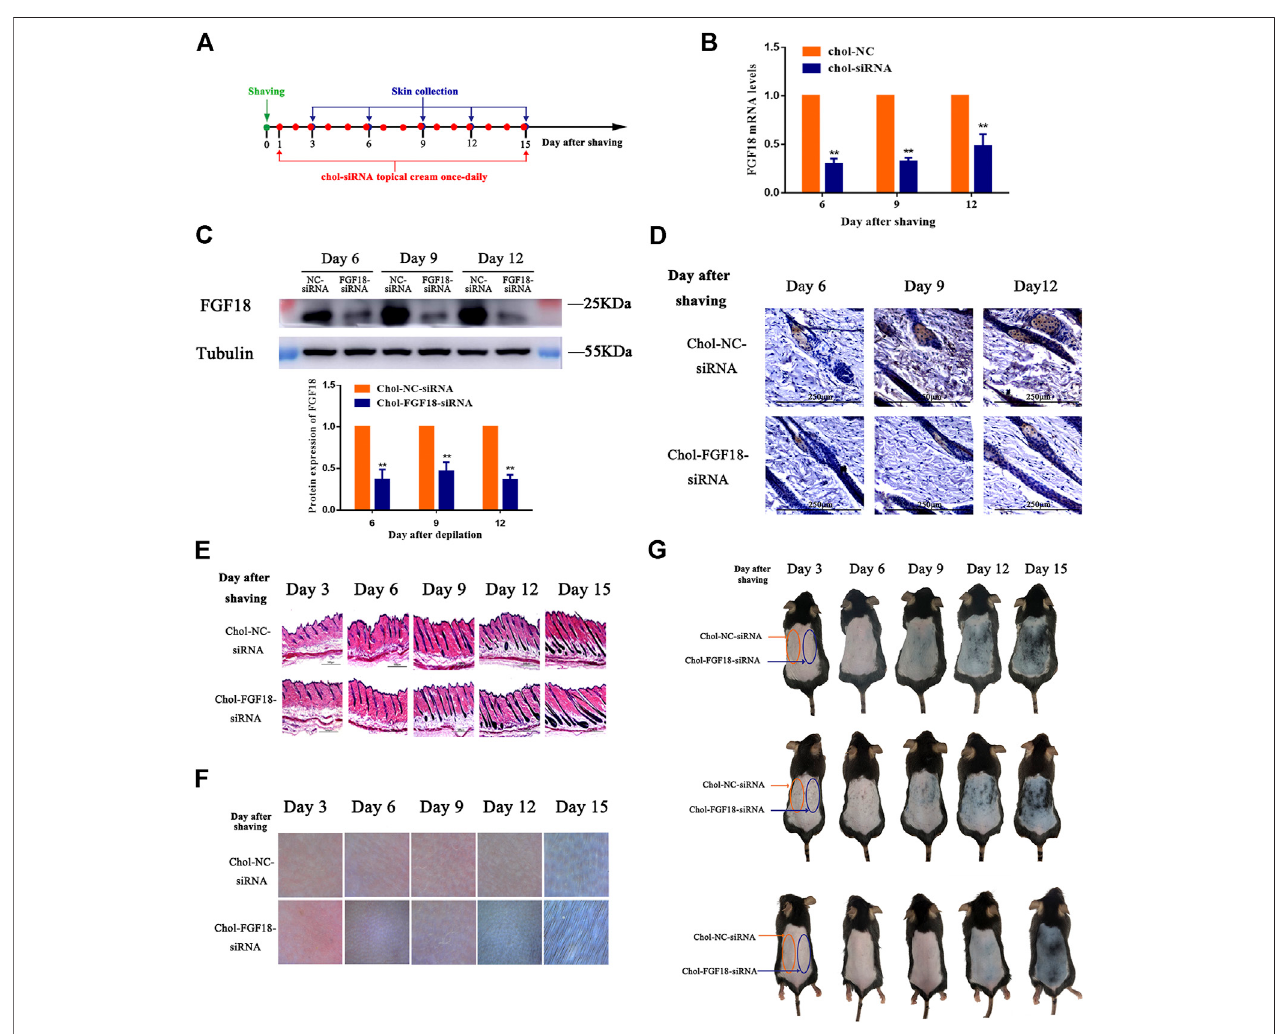
FIGURE4| Effects of topical application of FGF18-targeted siRNA cream on hair growth on mouse skin following depilation (A) Diagram depicting the timeline in the establishment of the model used for the topical application of Chol-FGF18-siRNA containing cream and collection of skin samples. A cream containing Chol- FGF18-siRNA or Chol-NC-siRNA was applied onto the skin one day after depilation, and changes in the mRNA level of FGF18 in the skin tissue were measured by qPCR (B) whereas changes in the protein level of FGF18 were measured by western blot (C) at the indicated times. The plot below the blot in (C) shows the quantitation of the protein bands in the blot as determined by the gray scale. Data are mean ± SD ( n (cid:2) 3). ** p < 0.01 vs. Chol-NC siRNA (D) Immunohistochemical staining of the skin tissue. (E) HE staining of skin tissue showing the different phases of the hair follicle cycle (F) Representative images showing the extent of hair growth on the skin as detected by a hair follicle detector at 200 × magni fi cation. (G) Representative images showing the back of the mice after depilation and administration of FGF18-targeted siRNA and NC-siRNA.